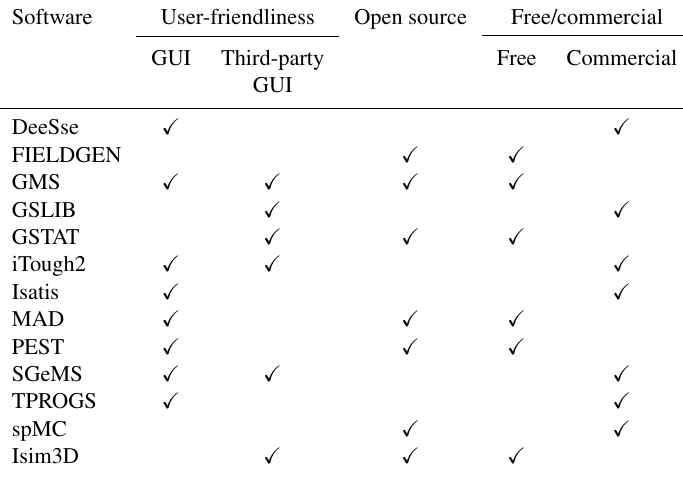
Table 3. Properties of reviewed stochastic software solutions. Third-party GUI indicates that one or more graphical user interface solutions are available for the listed program, but implemented in a separate solution than the listed program.